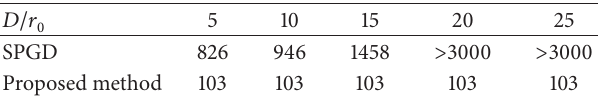
Table 1: Comparison of the number of intensity measurements of SPGD with that of the proposed method. 𝐷/𝑟 0 5 10 15 20 25 SPGD 826 946 1458 > 3000 > 3000 Proposed method 103 103 103 103